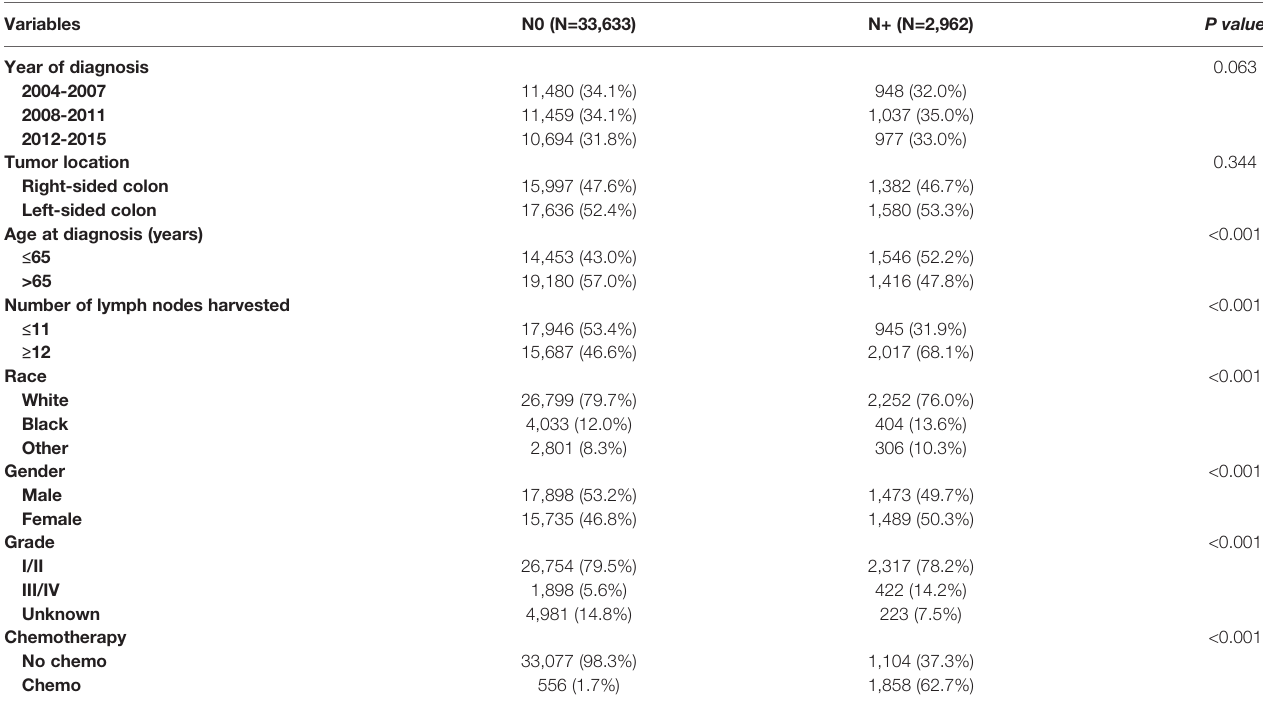
TABLE 1 | Clinicopathologic characteristics of T1 colon cancer patients according to the lymph node